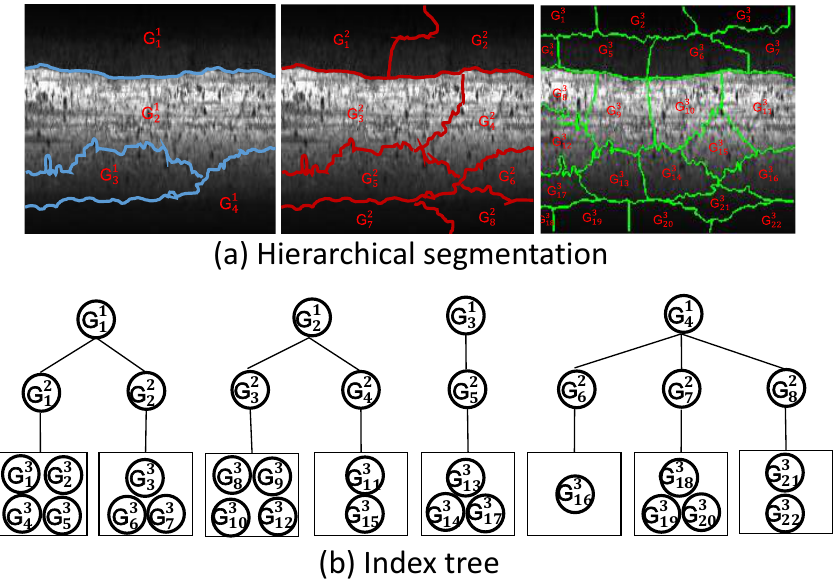
Figure 2. Construction of an index tree from an image. ( a ) Hierarchical segmentation of the input images. Digits are indices of the superpixels. ( b ) Index tree constructed over the pixels of the